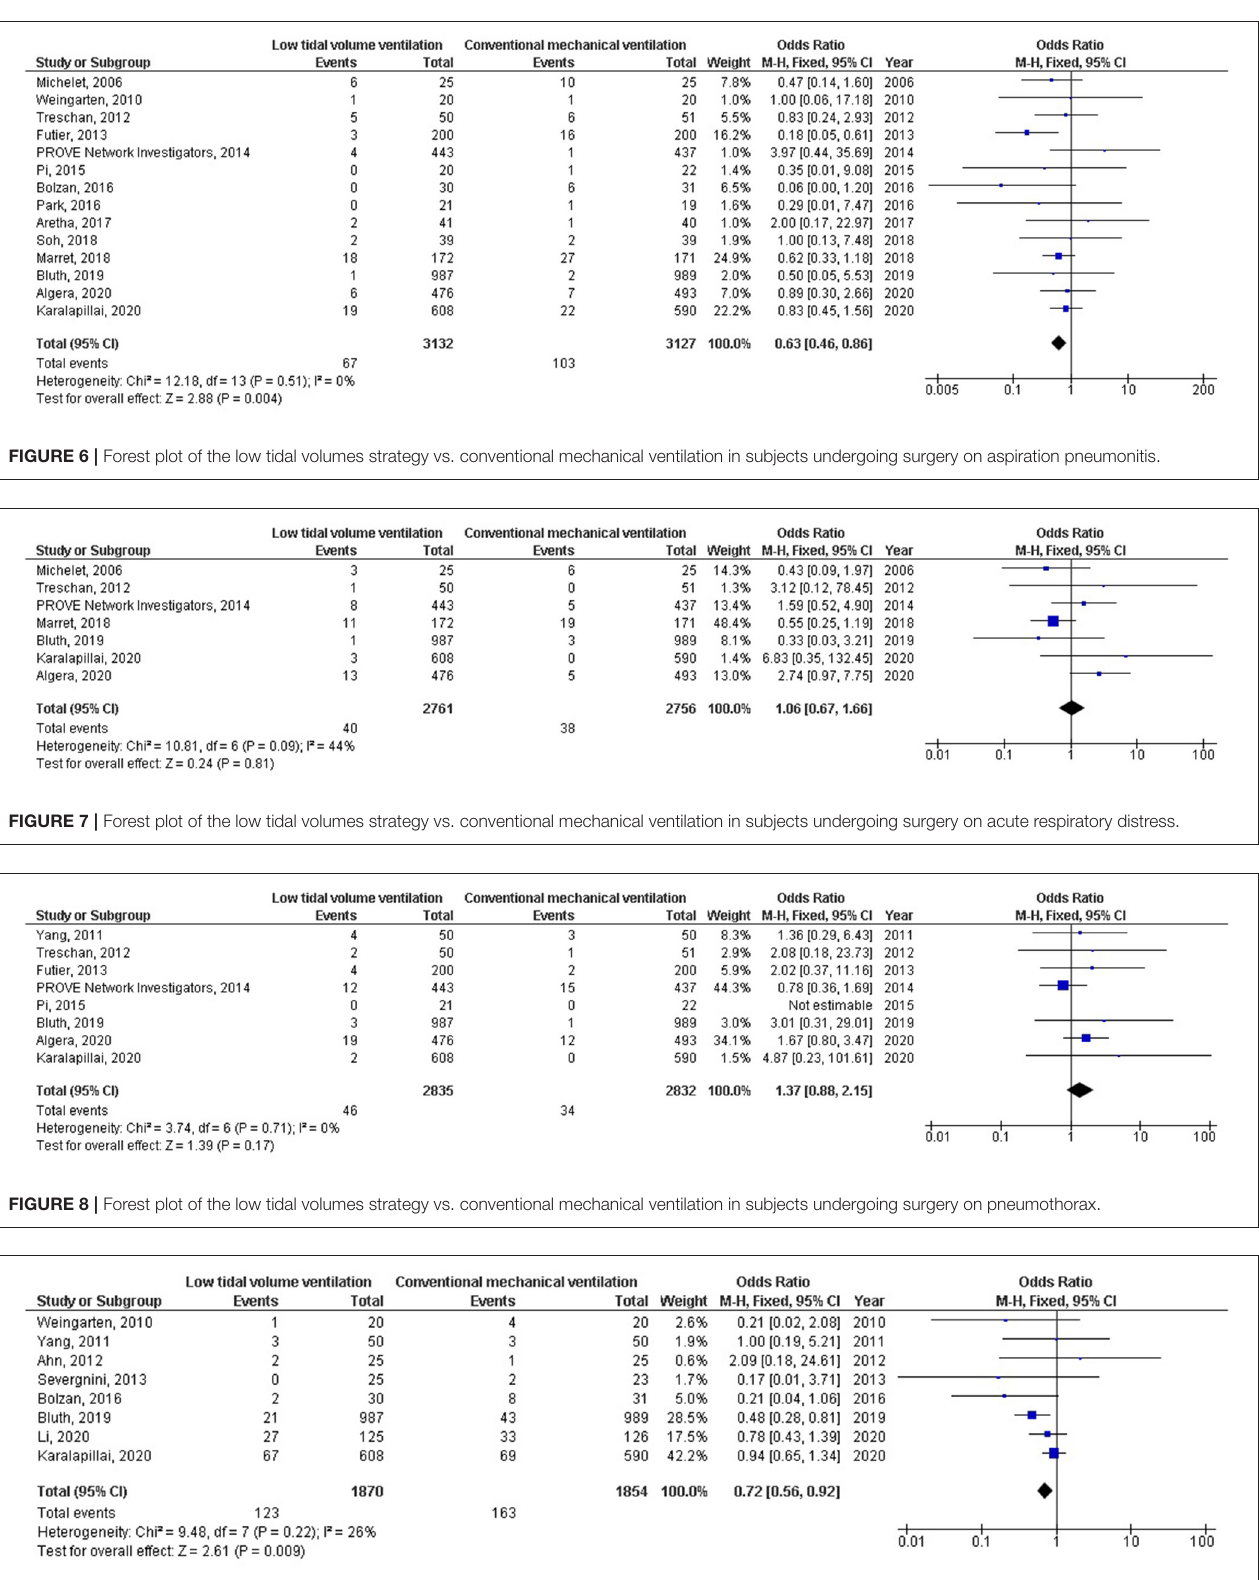
FIGURE 9 | Forest plot of the low tidal volumes strategy vs. conventional mechanical ventilation in subjects undergoing surgery on pleural effusion.